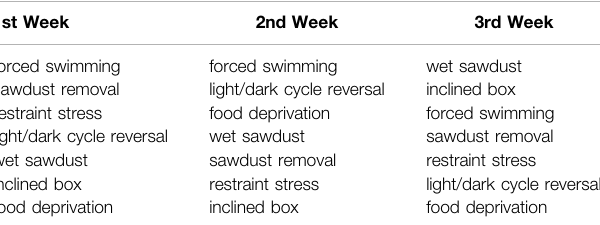
TABLE 1 | Detailed list of daily stressor used in the 3 week chronic unprectible stress